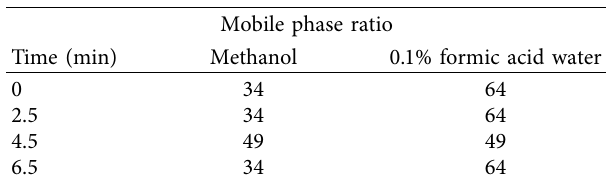
Table 2: Mobile phase